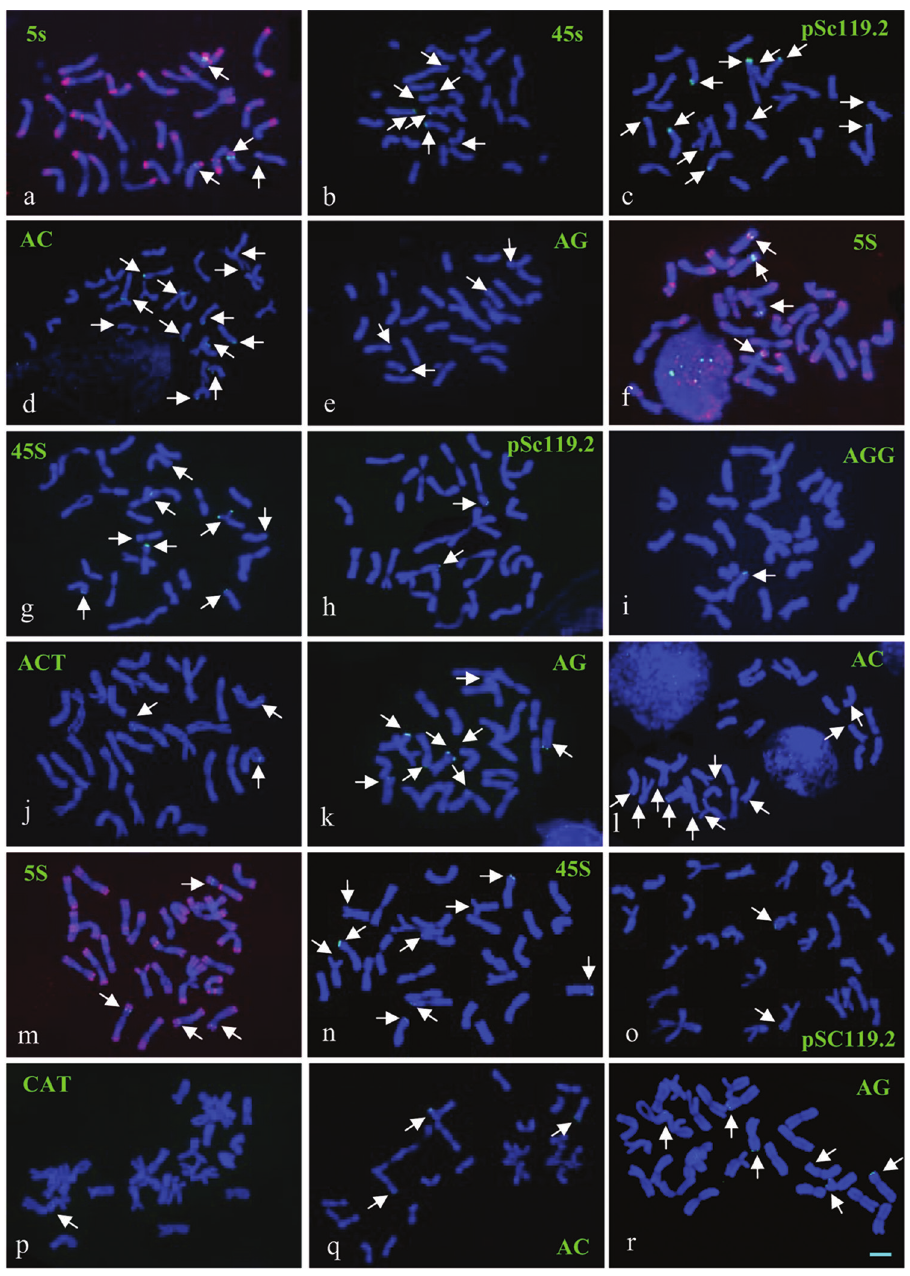
Figure 2. FISH patterns of mitotic metaphase chromosomes detected using pAs1 probes (red) com- bined with 5S rDNA, 45S rDNA, pSc119.2, AG, and AC probes in A. desertorum ( a–e ); 5S rDNA, 45S rDNA, pSc119.2, AAG, ACT, AG, and AC in A. fragile ( f–l ); 5S rDNA, 45S rDNA, pSc119.2, CAT, AC, and AG in A. michnoi ( m–r ) . The pAs1 signals (red) were removed artificially in all pictures except in ( a, f, m ). Arrows indicate the target signals (green). Scale bar = 10